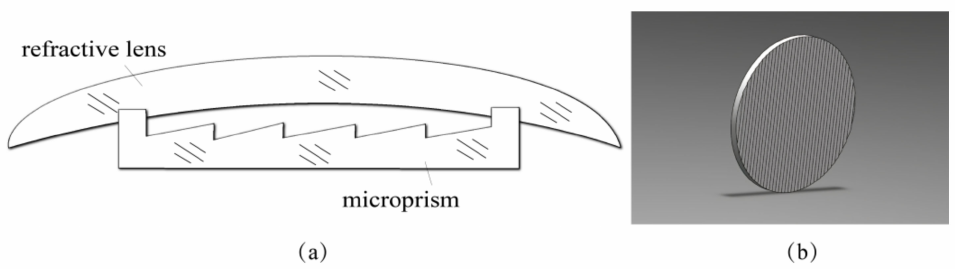
Figure 1. ( a ) Hermetic construction of glasses with microprisms; ( b ) diagram of a